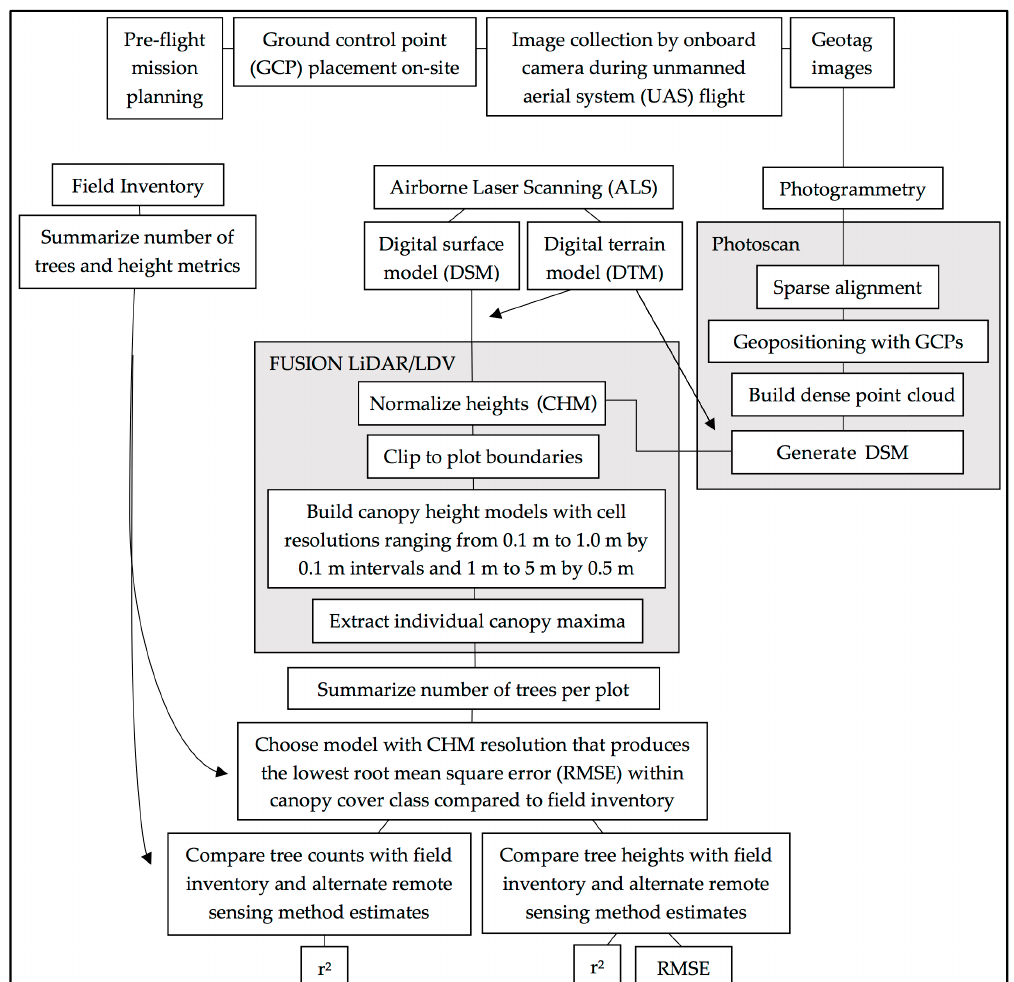
Figure 2. Flowchart of the methodology employed.